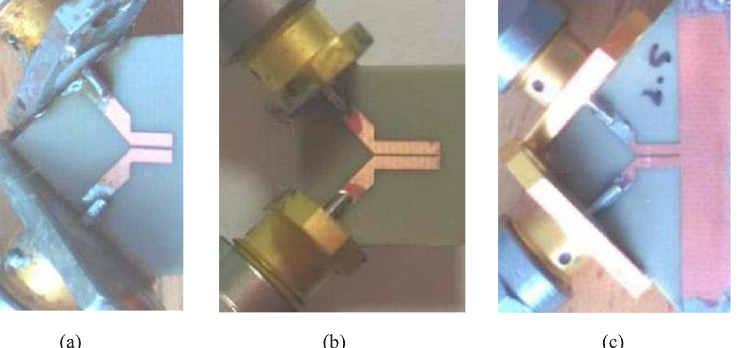
Figure 34. The fabricated coupled line sensors: ( a ) open-ended; ( b ) short ended with small connecting segment; and ( c ) short-ended with grounded connecting pad. Reprinted with permission from Ref.